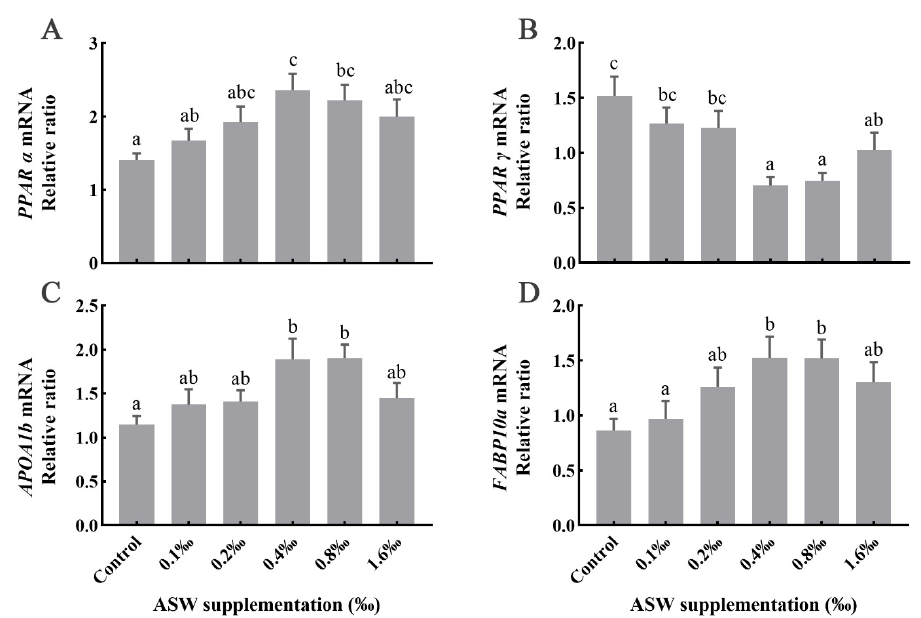
Figure 3. Expression levels of ( A ) PPAR α ; ( B ) PPAR γ ; ( C ) APOA1b ; and ( D ) FABP10a mRNA in the liver of GIFT fed with different ASW concentrations. Different superscript lowercase letters show a significant difference ( p < 0.05).